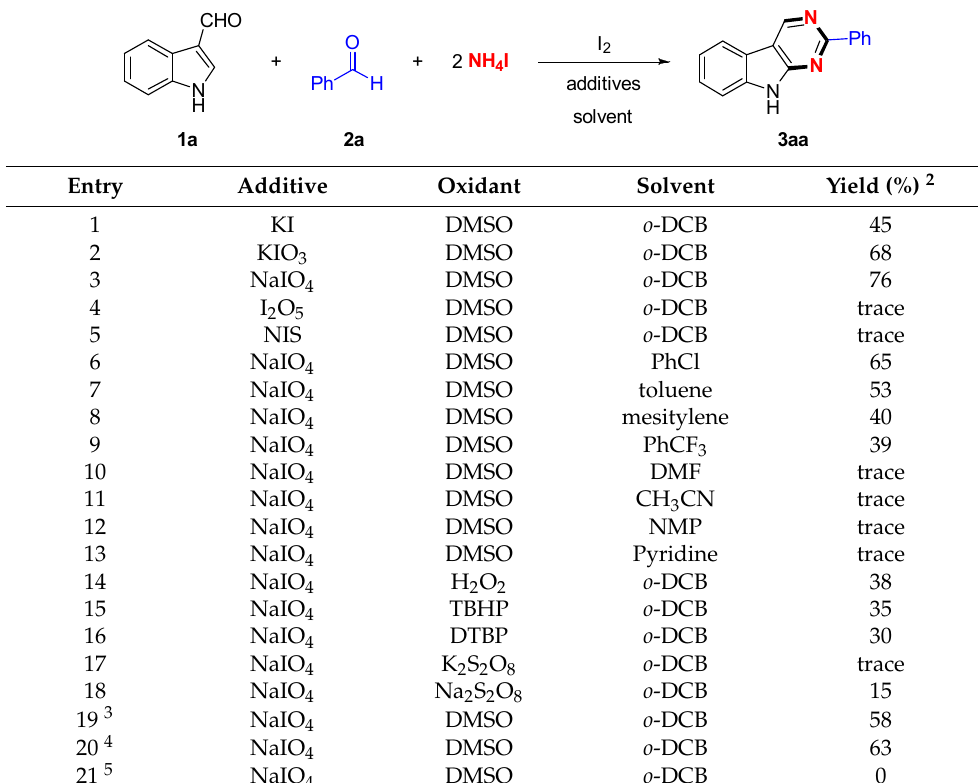
Table 1. Optimization of the reaction conditions 1 .